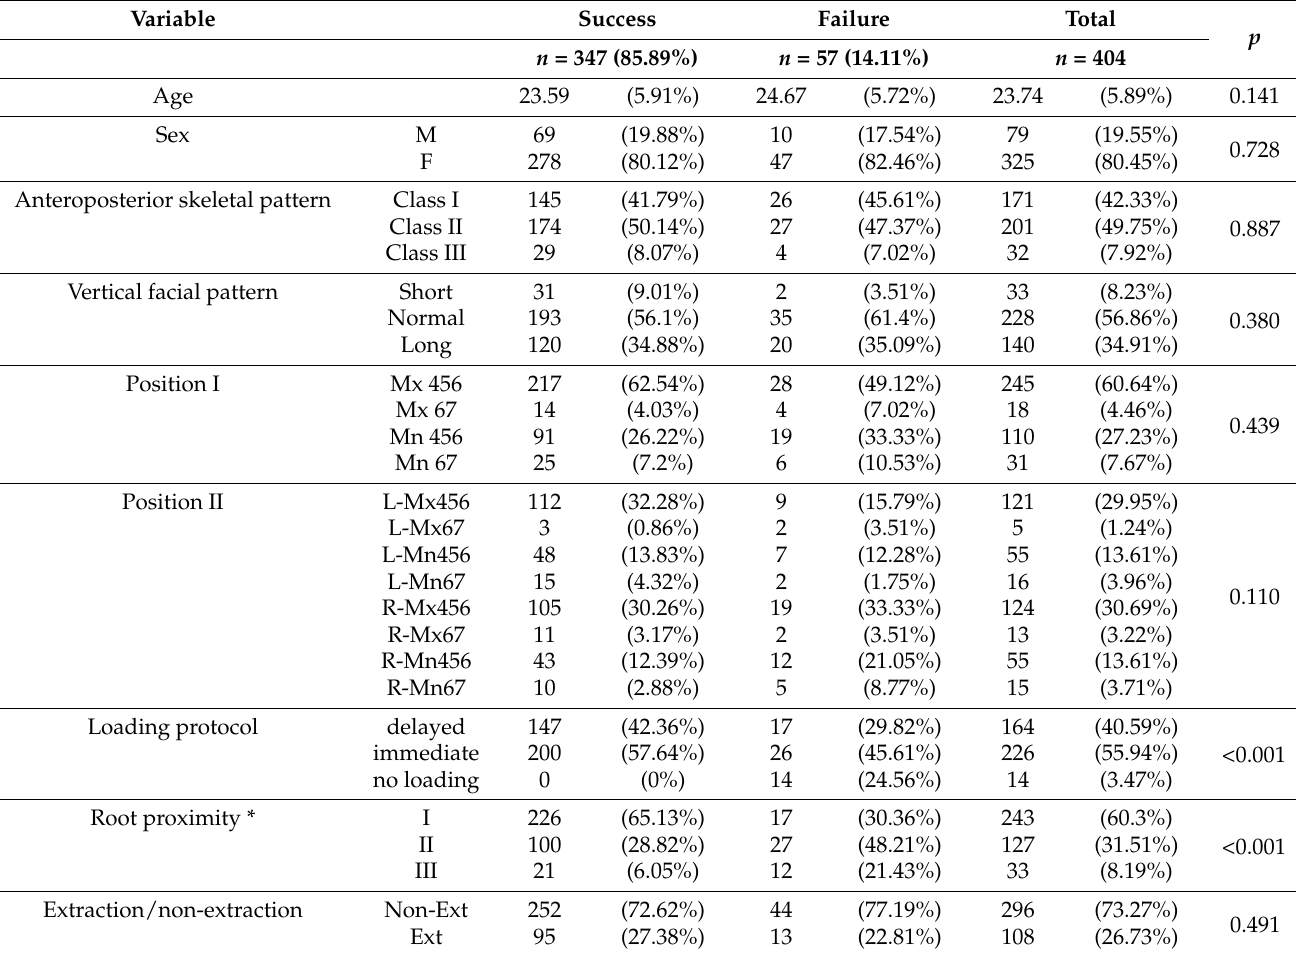
Table 2. Generalized estimating equation model (GEE) to assess the significant factors related to the success of micro-implants.